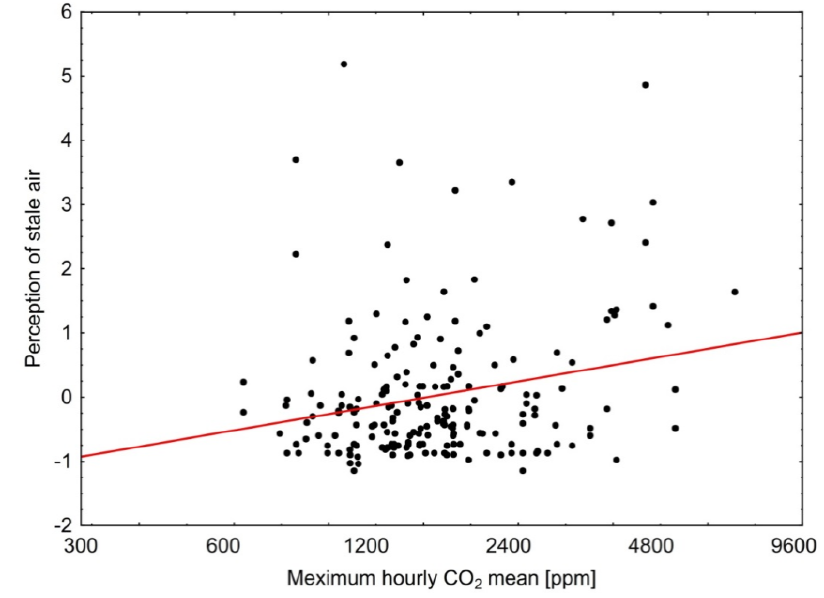
Figure 2. Correlation between maximum hourly mean of indoor CO 2 concentration (in bedrooms) and perception of stale indoor air (standardized score) at T2 (about 1.3 years after moving in) (R 2 =